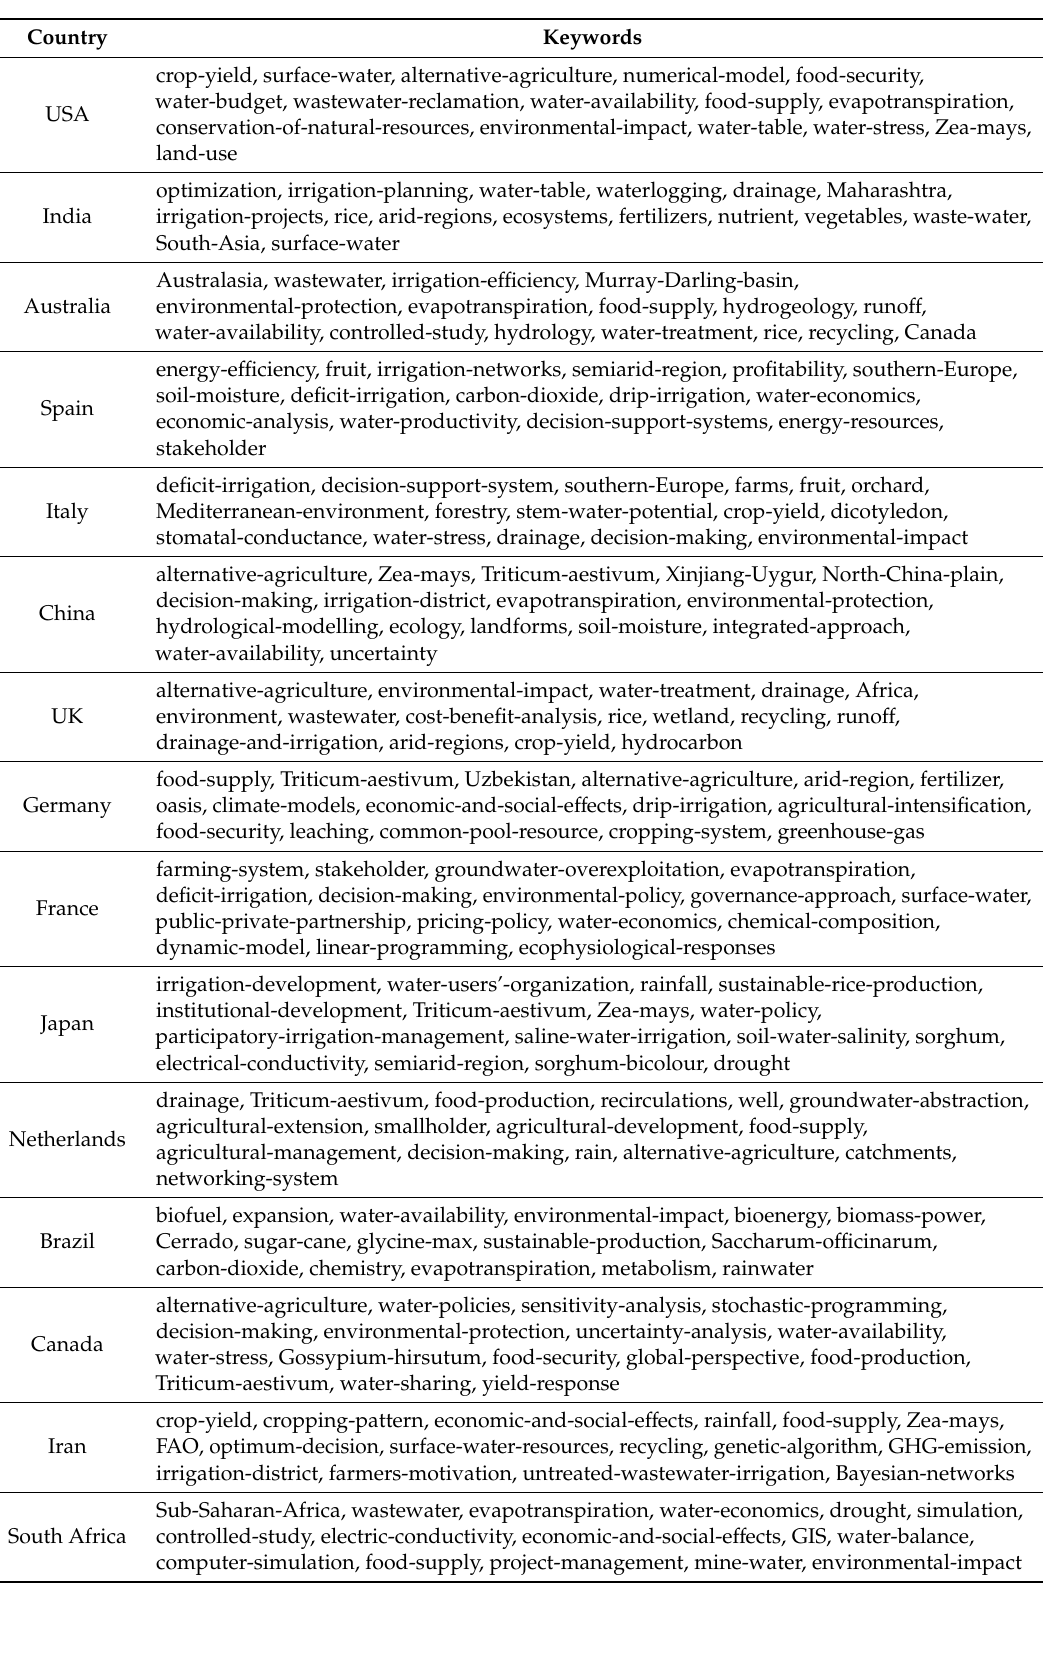
Table 5. Main keywords of the most active countries related to SI